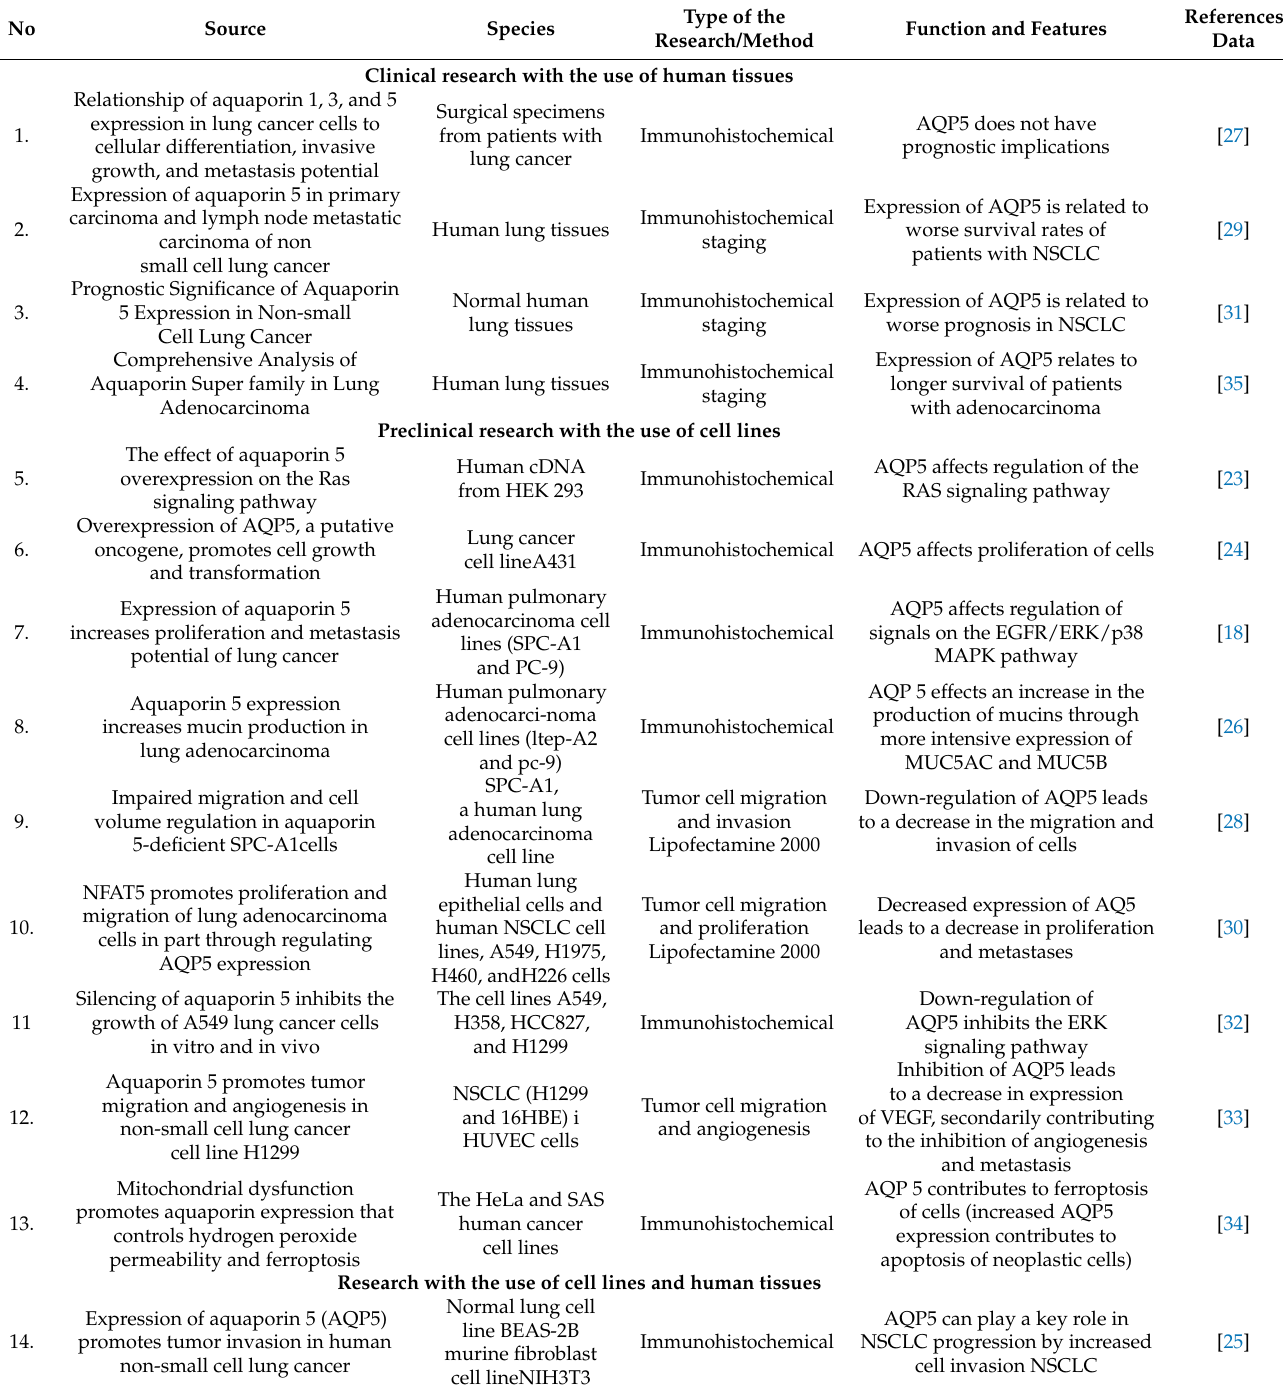
Table 2. Role of aquaporins in biology of